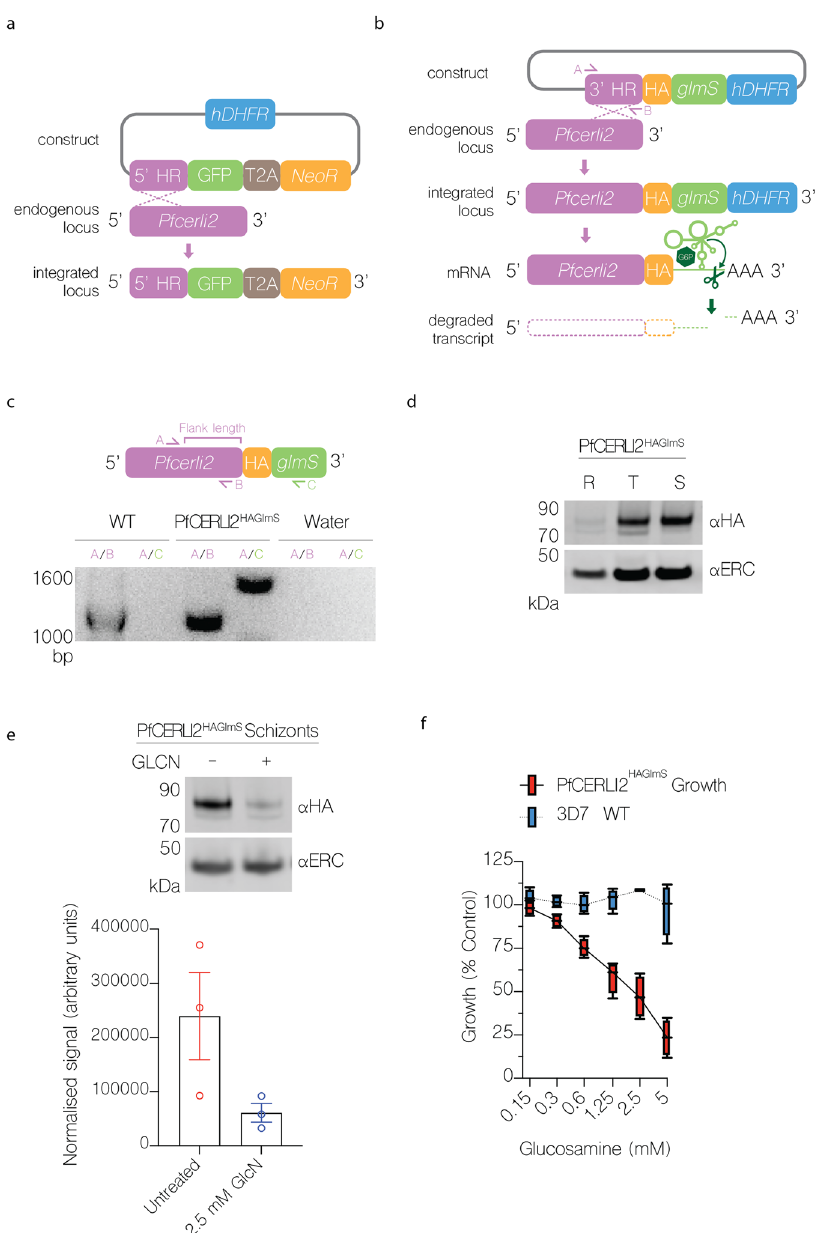
Fig. 2 PfCERLI2 is essential for blood-stage growth. a Schematic representation of the selection linked integration targeted gene disruption (SLI-TGD) system used for the attempted gene knockout of Pfcerli2 . b Schematic representation of the haemagglutinin (HA) tag, and GlmS ribozyme system used to identify and knockdown PfCERLI2. A plasmid that contained a 3 ′ Pfcerli2 fl ank (2154bp-2912bp) with an HA-tag and GlmS ribyzome was transfected into 3D7 parasites by single crossover recombination. Following mRNA production, glucosamine-6-phosphate (G6P) binds to the GlmS ribozyme, leading to the cleavage of Pfcerli2 mRNA and subsequent protein knockdown. c To con fi rm integration of the Pfcerli2 HAGlmS plasmid, gDNA was harvested from transfected parasites. A Pfcerli2 speci fi c forward primer, A, with either a Pfcerli2 speci fi c, B (WT), or GlmS speci fi c, C (integrated), reverse primer was used to con fi rm WT DNA sequence or integration of the Pfcerli2 HAGlmS plasmid. d Western blot of ring, trophozoite, or schizont stage PfCERLI2 HAGlmS lysates probed with either anti-HA (PfCERLI2) or anti-ERC (loading control) antibodies. N = 3 biological replicates. e Western blot of PfCERLI2 HAGlmS schizont lysates either GLCN treated ( + ) or untreated ( − ) and probed with anti-HA (PfCERLI2) normalised to ERC (loading control) antibodies. A graph quantifying the relative level of expression between treatments. N = 3 biological replicates, error bars = SEM. f PfCERLI2 HAGlmS or 3D7 WT parasites were treated with increasing concentrations of GLCN for 72 h, with the trophozoite-stage parasitaemia determined by fl ow cytometry. Growth is expressed as a percentage of an untreated media control. n = 4, box represents the 25th to 75th percentile, median and maximum value are shown. X-axis presented as a log 2 scale for viewing purposes.